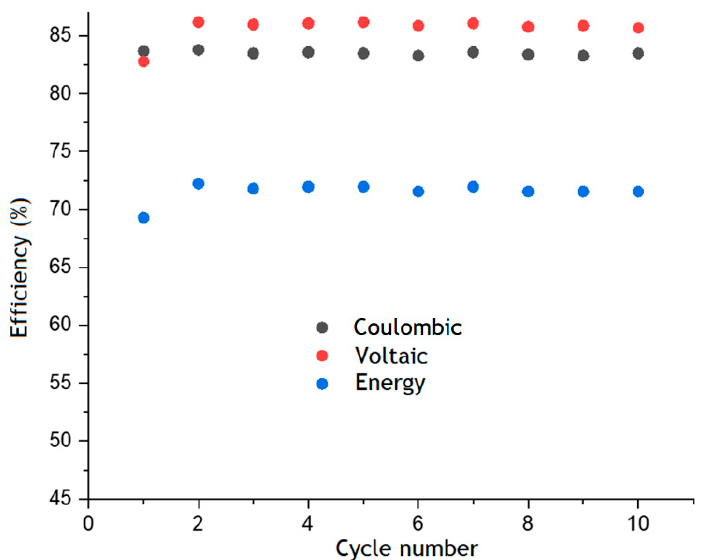
Figure 6. Faraday, voltaic and energy efficiency of AQBRFB estimated from the results of cyclic charge–discharge tests. Cycling conditions: 50 mA cm − 2 in the voltage range 0.6–1.6 V. Membrane: Nafion-211, temperature: 50 ◦ C, flow: through flow field, flow rate: 100 mL min − 1 Posolyte composition: 1 M LiBrO 3 in 6 M H 2 SO 4 , negolyte composition: 0.8 M AQDSH 2 in 1 M H 2 SO 4